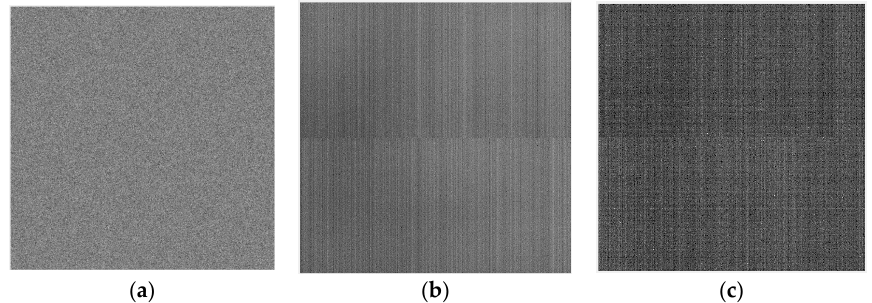
Figure 5. The effect of flat field correction ( a ) corrected results after CIS working for 15 min; ( a ) corrected results after CIS working for 15 min; ( b ) corrected results after CIS working for 1 h; ( c ) corrected results after CIS working for 3 h.